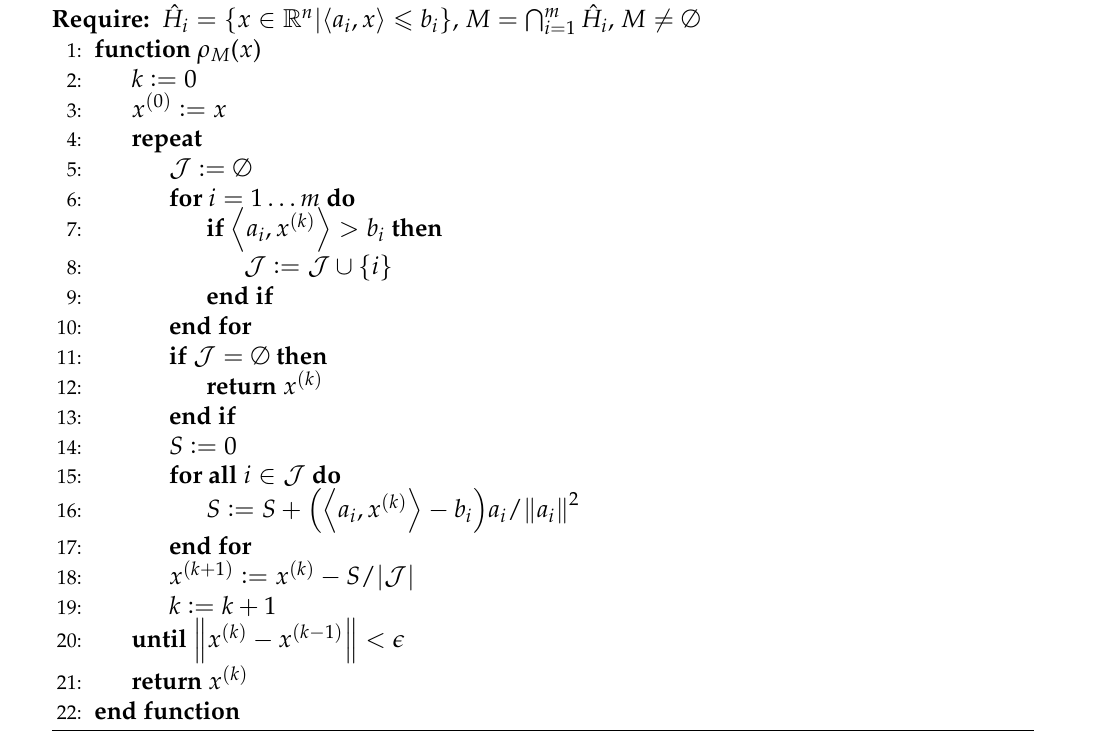
Algorithm 2 Parallel calculation of a pseudoprojection.